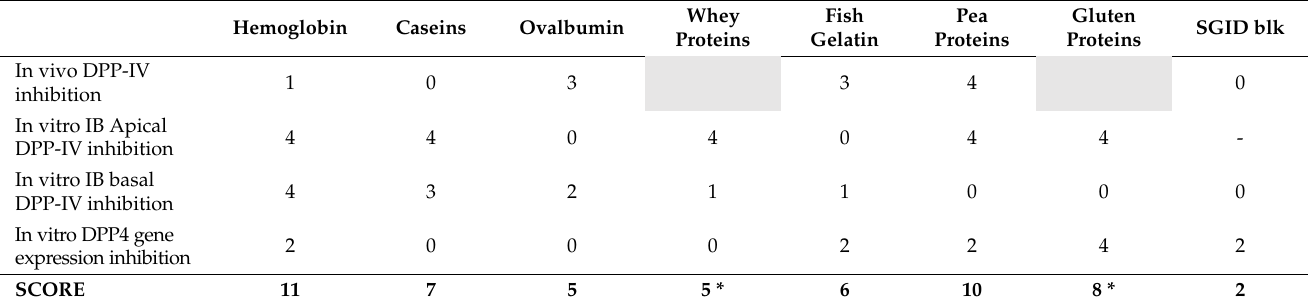
Table 4. Global assessment of the DDP-IV-inhibitory potential of protein from different